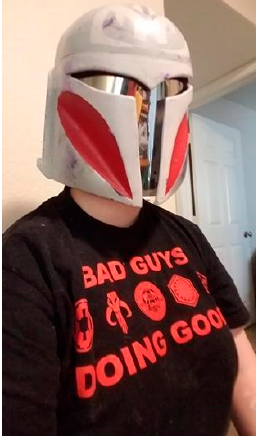
Figure 2. “This is my face”